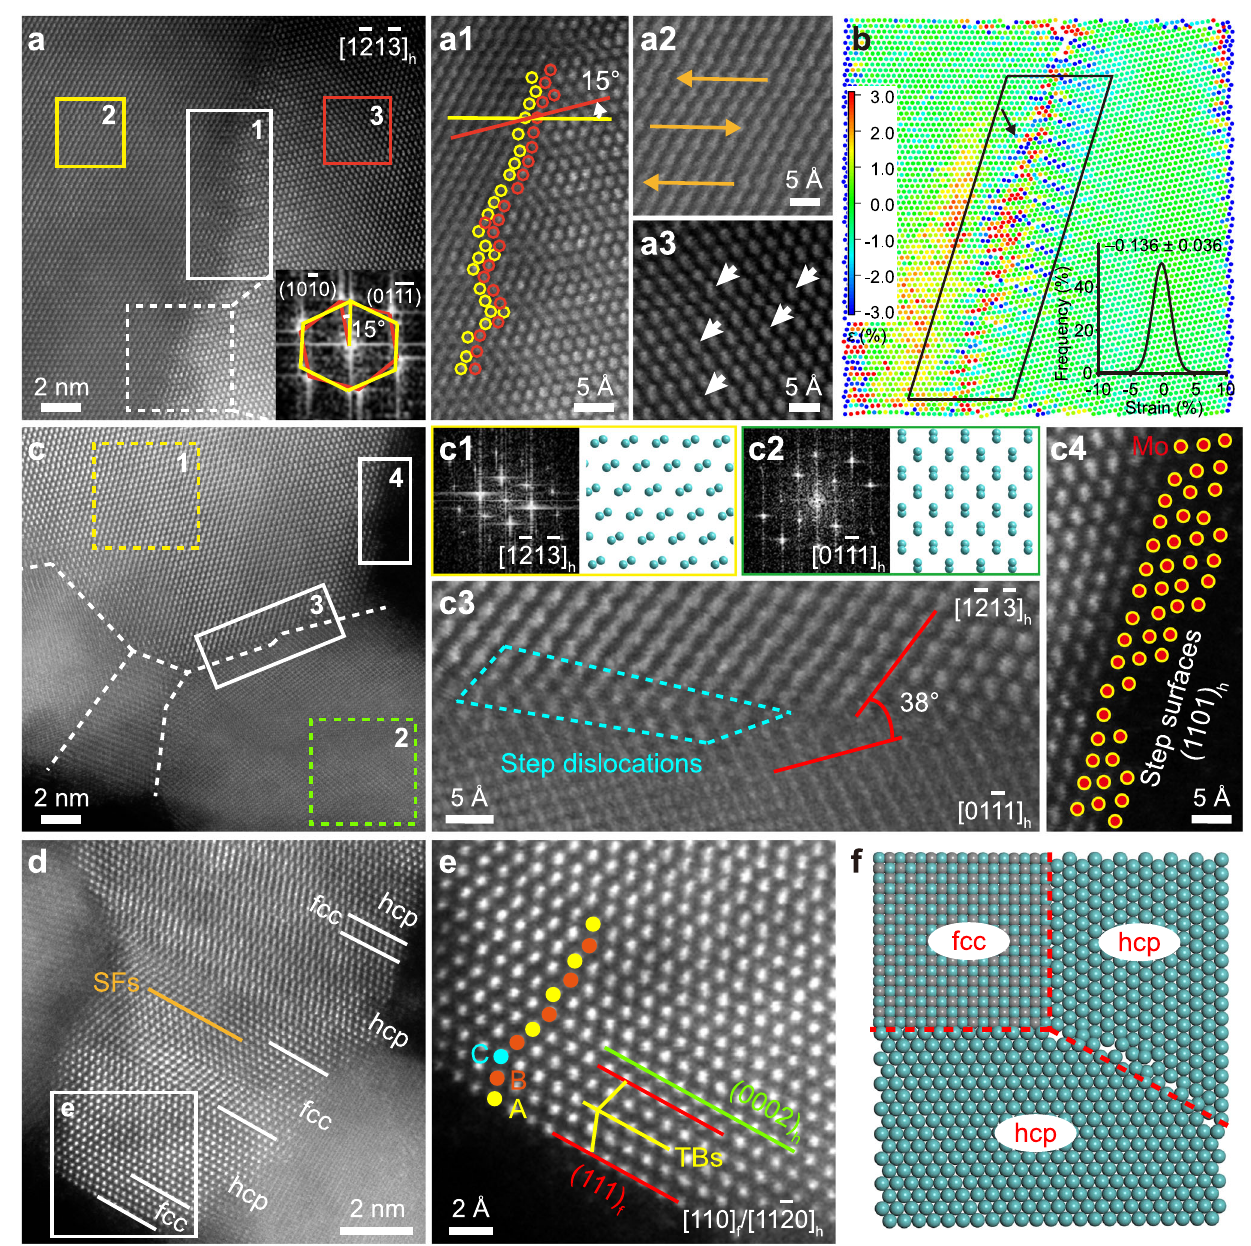
Fig.3|LocalatomicstructureofGBsonMo 2 CNSsinH-Mo 2 C/NG.a AtiltedGBin Mo 2 C NS.Insetofthe FFTpatternindicatesa15° misorientationbetweengrains. a1 Enlarged HAADF-STEM image of region 1 in a . Yellow and tangerine circles repre- sent the Mo atoms on the left and right sides of GB, respectively. a2 , a3 Enlarged HAADF-STEM images of regions 2 and 3 in a . The orange and white arrows repre- sent SFs and displacements, respectively. b Lattice shear distortion determined from panel a , analyzed using the lattice distortion analysis (LADIA) programme. Insetisthequantitativedistributionofshearstrainforatomsinblack-boxedregion. The arrow indicatesthe direction ofstrain. The strains nearGBsrangefrom – 5%to 5%. The atoms are colored according to strain scale, that is, colors for positive valuesrepresenttensilestrainandthosefornegativevaluesrepresentcompressive strain. c The hcp/hcp lattices along the [1 213] h /[0111] h direction, the white dashed lines point out the irregular GBs. c1 , c2 FFT patterns taken from regions 1 and 2 in c , and the corresponding projected supercell models of hcp Mo 2 C. The cyan balls